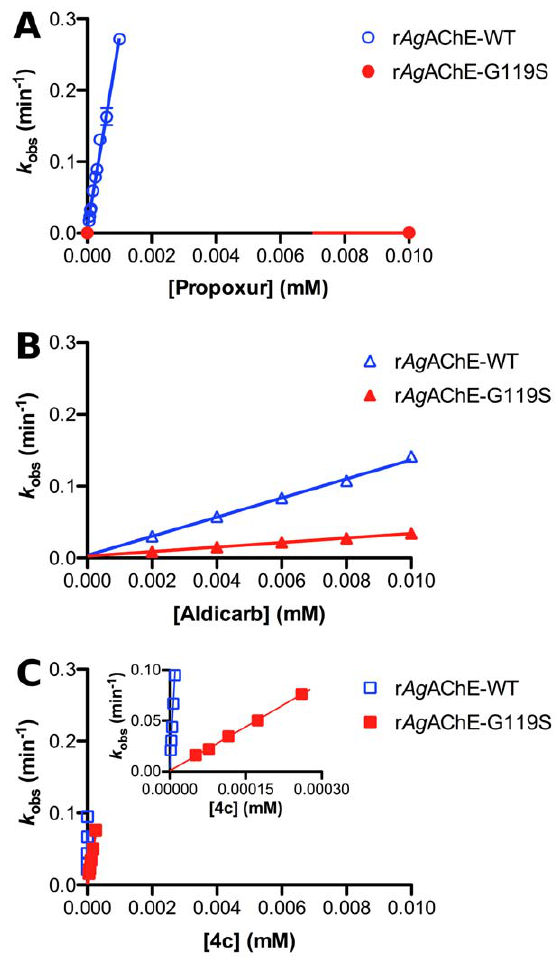
Figure 5. Plots of k obs vs [carbamate] at both r Ag AChE-WT and r Ag AChE-G119S for three inhibitors. A) propoxur; B) aldicarb; C) 4c . Second-order rate constants for inactivation k i (mM 2 1 min 2 1 ) derive from the slope of each line. For clarity the data for 4c are also plotted on expanded axes (inset). mg, Table 1). Interestingly, our measured k cat value